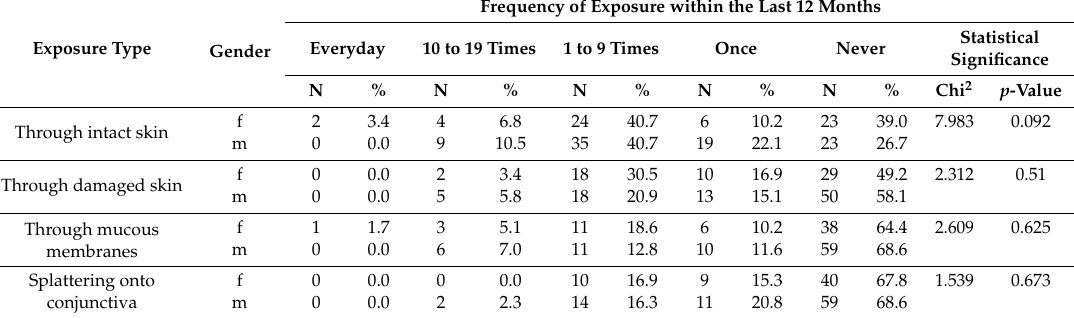
Table 2. Frequency of paramedics’ contacts with potentially infectious material within 12 months preceding the